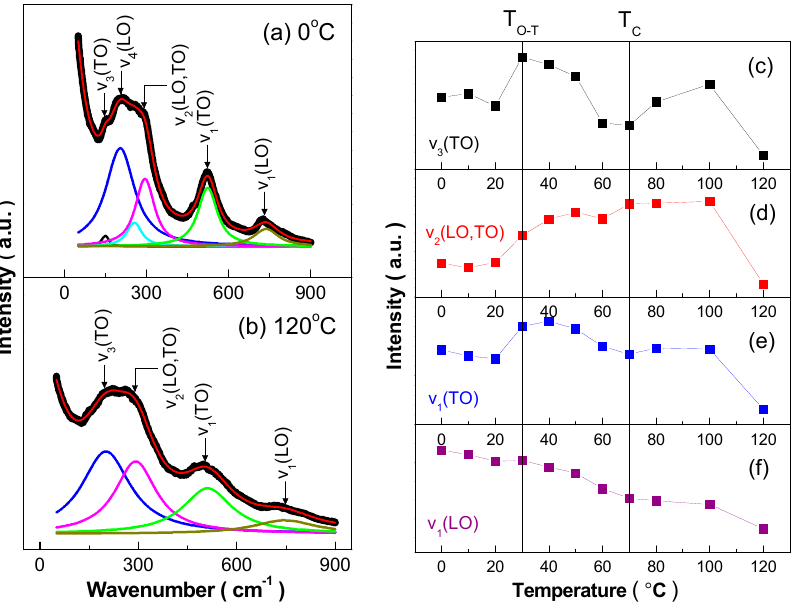
Figure 5. Lorentzian deconvolution peaks of Raman spectra using ( a ) 0 °C and ( b ) 120 °C as examples;